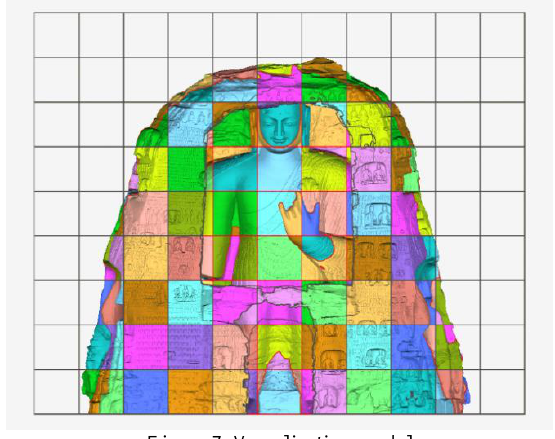
Figure 7. Voxelization model